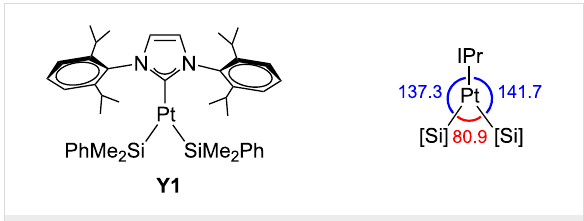
Figure 3: Neutral Y-shaped Pt complex Y1 [15]. Angles are given in